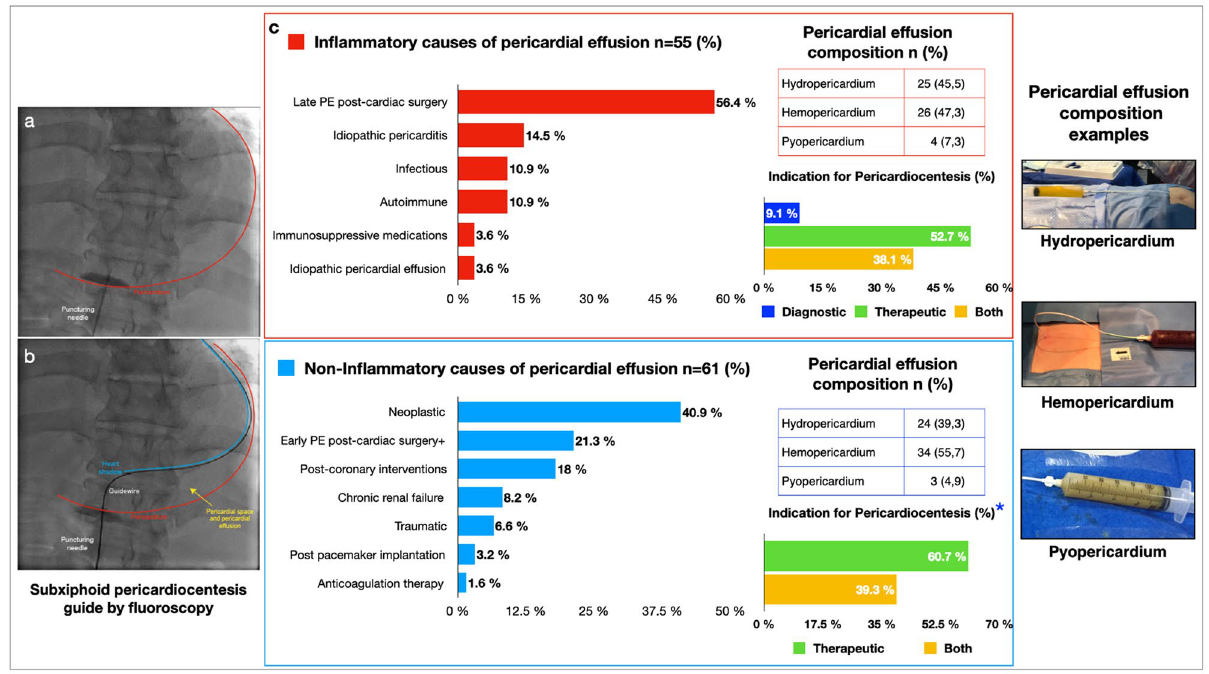
Figure 1. Central illustration. ( a ) Fluoroscopy guidance pericardiocentesis with the puncturing needle crossing the pericardium (red line). ( b ) Guidewire around the heart shadow (blue line) and pericardium space that contains PE between the pericardium and heart shadow (yellow arrow). ( c ) Percentages of specific causes in the inflammatory and noninflammatory groups. Percentage of diagnostic, therapeutic or both indications for pericardiocentesis in the inflammatory and noninflammatory groups. *There were no cases of only diagnostic indication for pericardiocentesis in the non-inflammatory group. Percentage of pericardial effusion composition in the groups and pericardial effusion composition